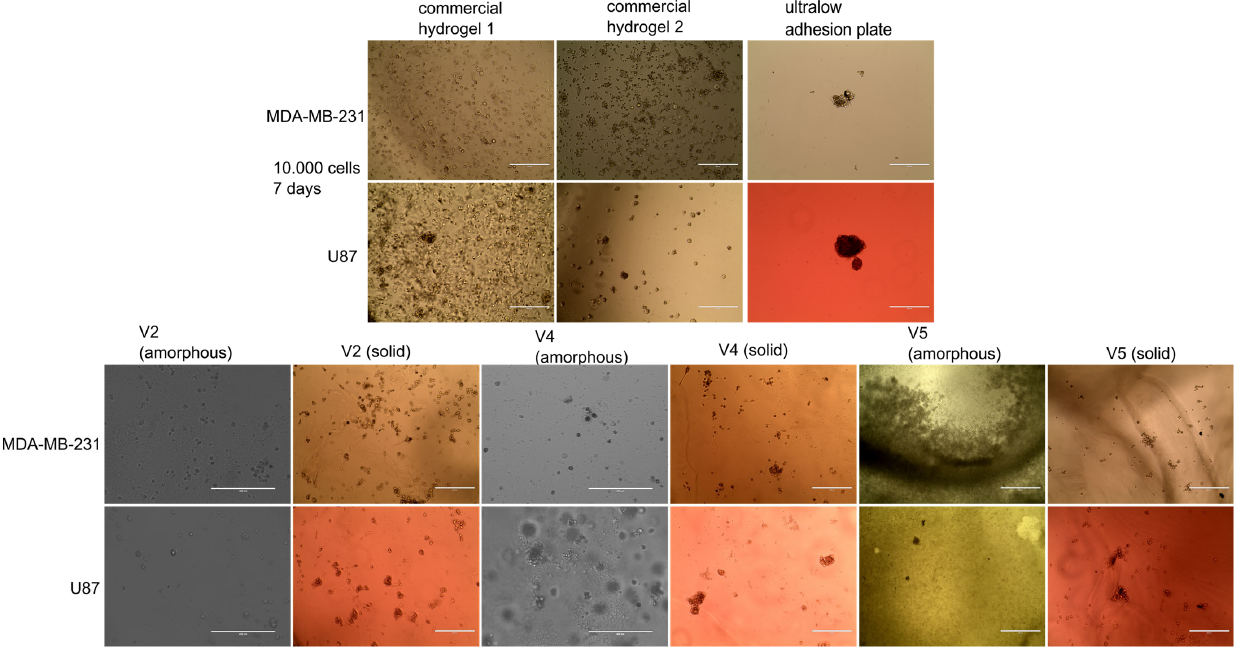
Figure 4. Microscope images for spheroids formed at 7 days in the developed gels. 10,000 cells of MDA ‐ MB ‐ 231 and U87 were seeded in amorphous and solid hydrogels and incubated for 7 days in their respective complete media, with medium change on the 3rd and 6th day. 10×, phase contrast. Scale bar 400 μ m.